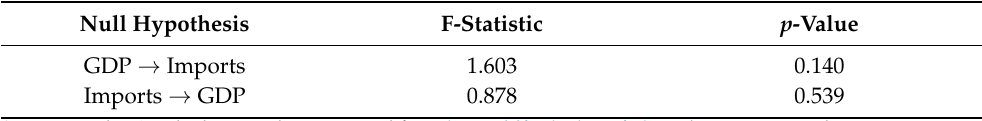
Table 2. Granger Causality Test, PRC, 8 lags,